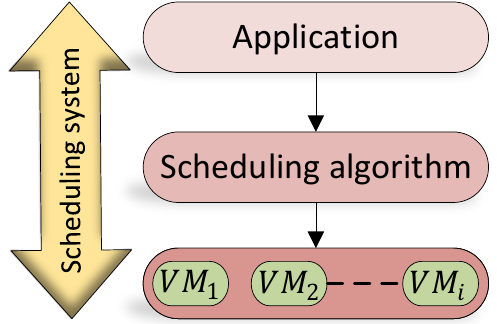
Figure 2. Scheduling system